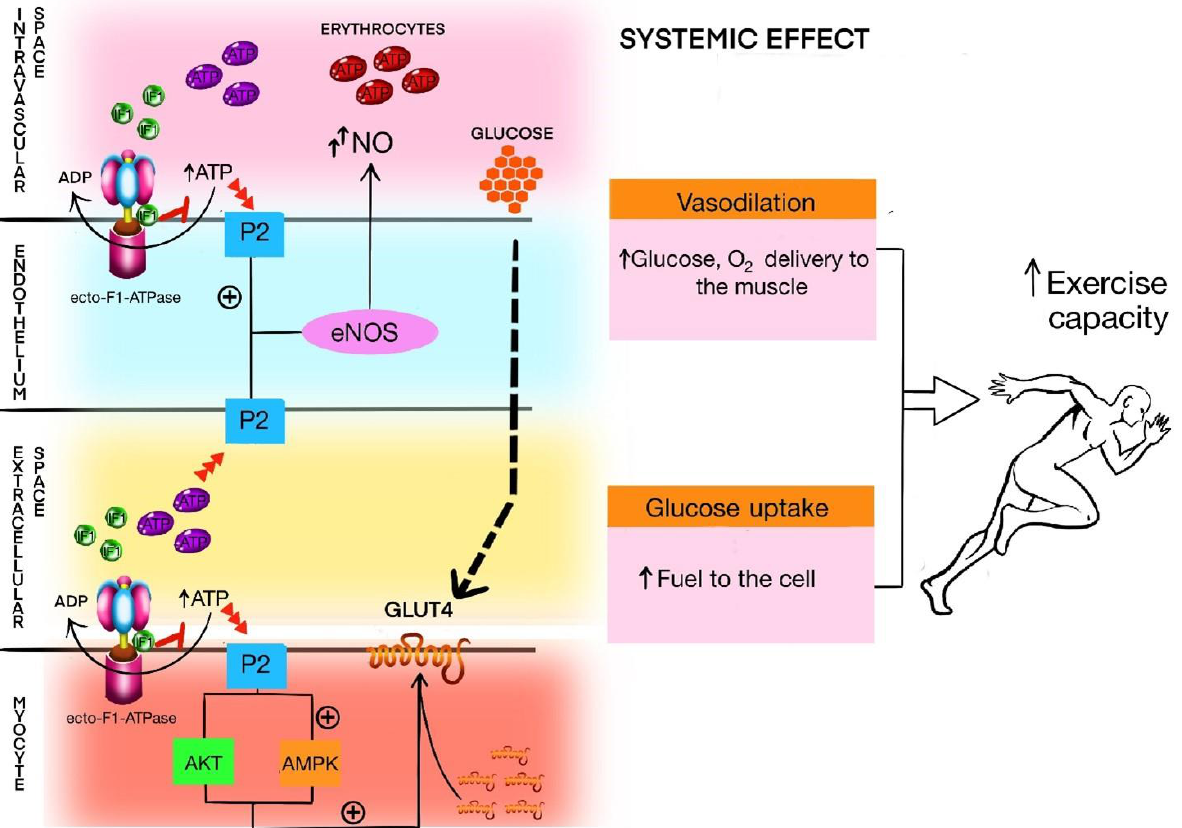
Figure 2. Potential modulation of purinergic signaling by IF1. In intravascular and extracellular space, IF1 binds to ecto-F1-ATPase and inhibits its hydrolytic activity, increasing the pool of circulating ATP. This ATP acts with purinergic P2 family receptors, which, in endothelial cells, activate nitric oxide synthase (eNOS) and nitric oxide (NO) production, thus leading to vasodilation. In muscle cells, an increased pool of extracellular ATP could activate purinergic receptors outside the cell membrane, in turn activating Akt and AMPK kinases. When activated, kinases, AMPK and Akt trigger GLUT4 translocation to the cell surface, thus increasing glucose uptake. Due to vasodilation, the blood delivers more glucose and oxygen to the working muscle. Increased glucose uptake sustains proper glucose delivery to the cell during exercise. Both vasodilation and increased glucose uptake contribute to increased exercise capacity/performance.